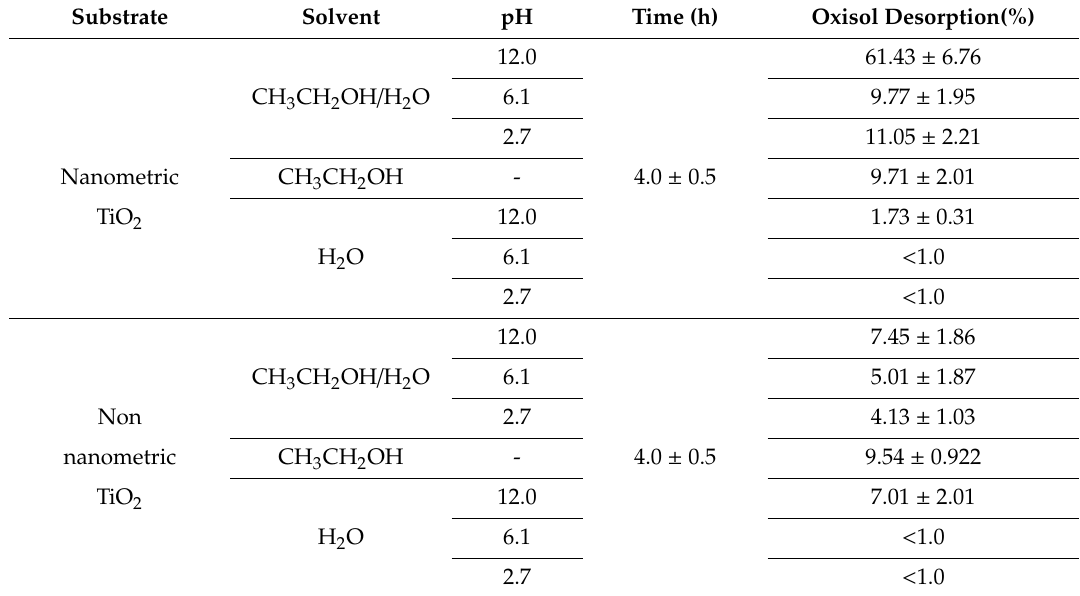
Table 6. Oxisol release from particles in di ff erent solvents and pH value for coated TiO 2